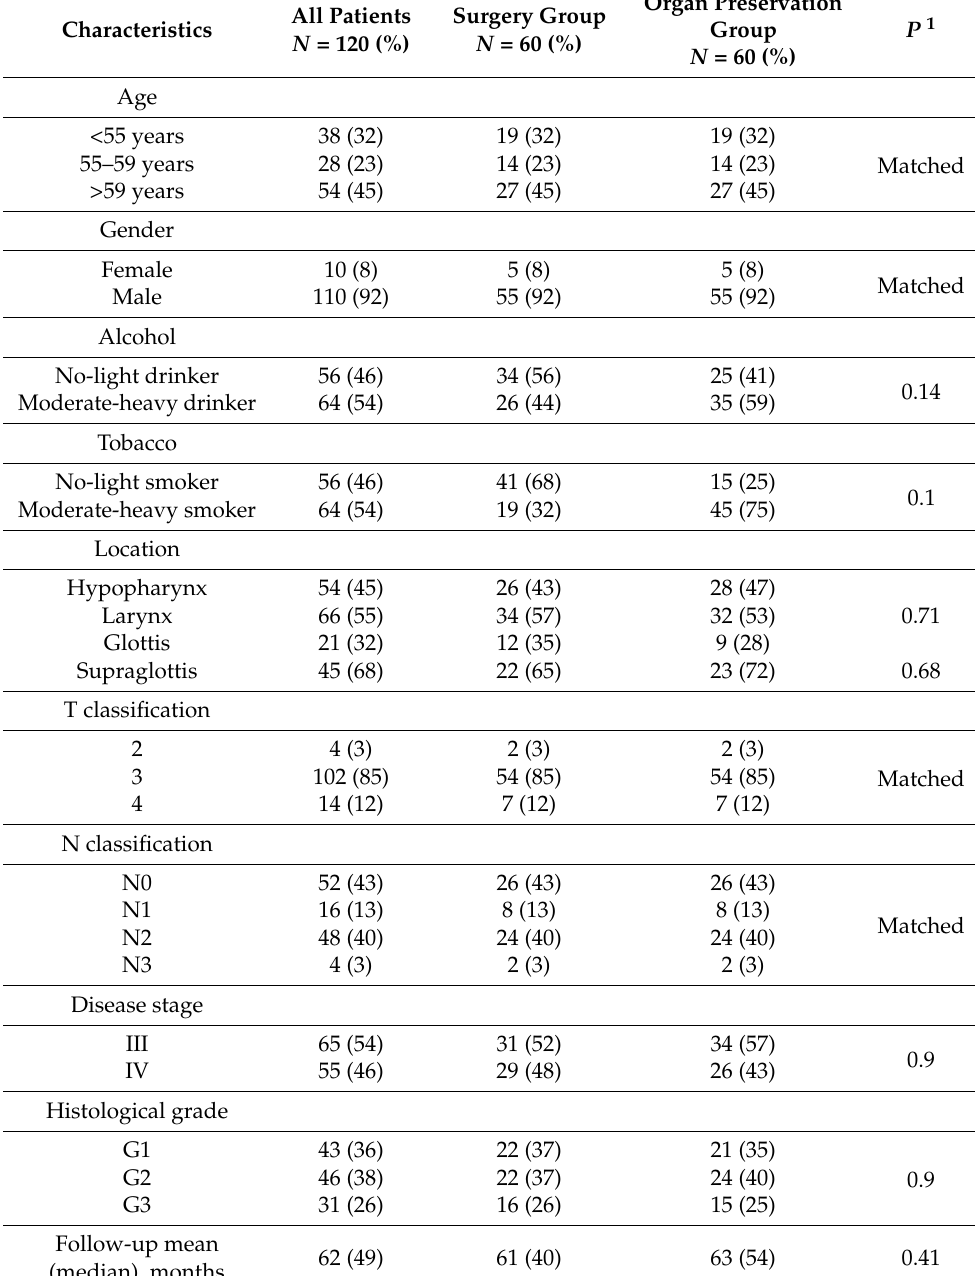
Table 1. Patient